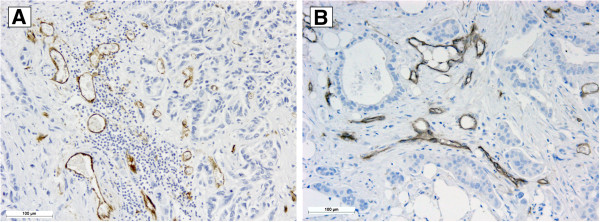
Microphotograph of pancreatic adenocarcinoma. A- Hotspot showing blood vessels stained by immunohistochemistry with CD34 antibody. B- Hotspot showing lymphatic vessels stained by immunohistochemistry with D2-40 antibody.